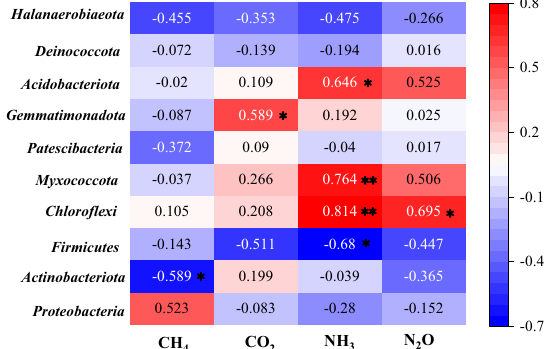
Fig. 7 Correlation analysis between gaseous emissions and microbial relative abundance in phyla level based on the spearman correlation. The right side of the legend is the color range of different r values. Red is positive and blue is negative correlation. The value of p < 0.05 is marked with *, p < 0.01 is marked with